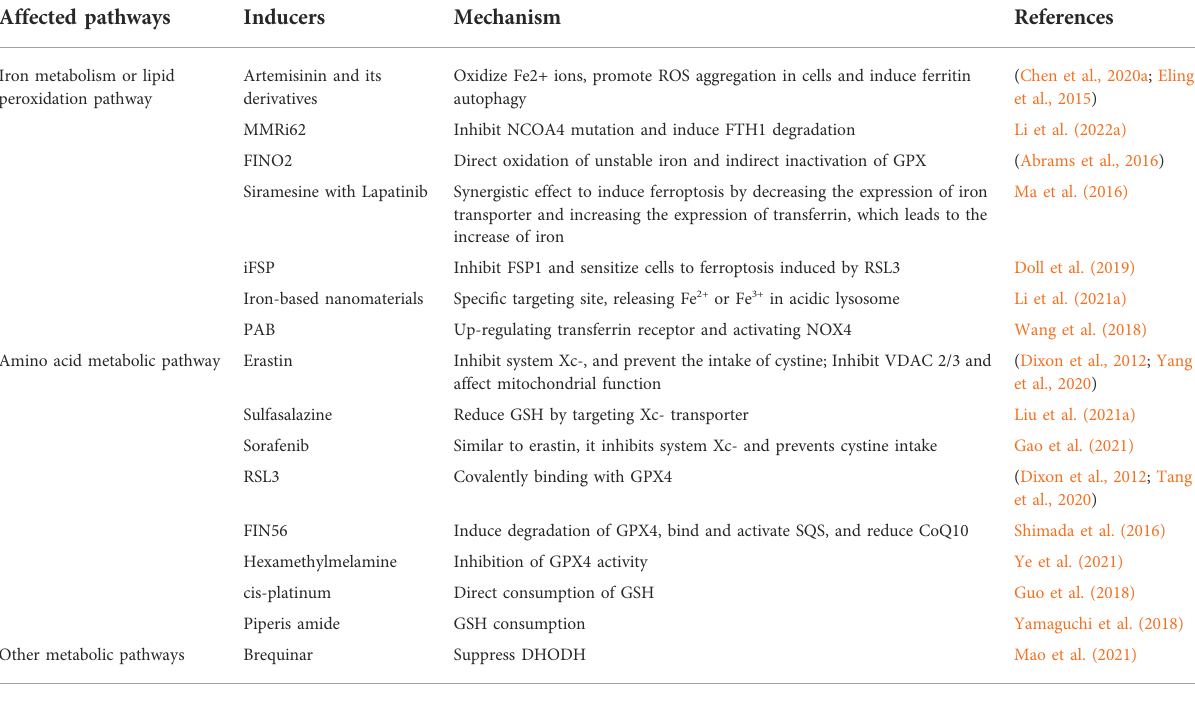
TABLE 1 The ferroptosis inducers.